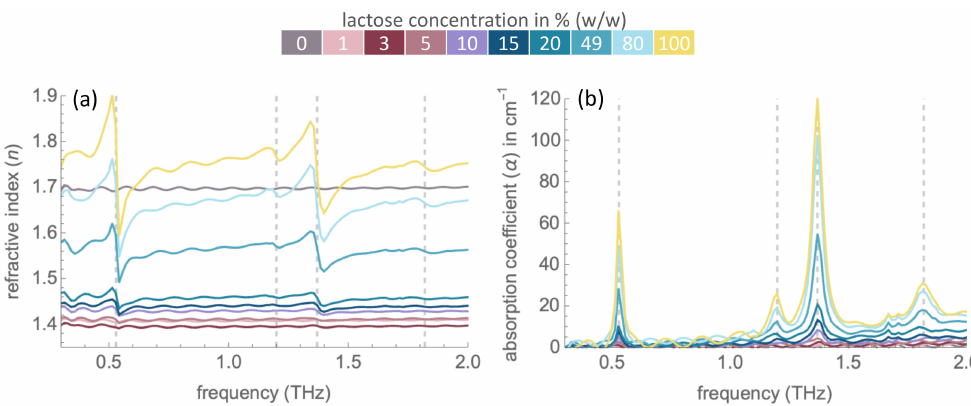
Figure 2. ( a ) THz refractive index ( n ) and ( b ) absorption coefficient ( α in cm − 1 ) spectra of α -lactose monohydrate at varying concentrations under nitrogen-rich atmosphere. Frequencies of absorption peaks (0.53 THz, 1.20 THz, 1.37 THz, 1.82 THz) are signified by vertical dashed lines. The calculation of refractive index and absorption coefficient are described in Equations (2) and (3) under Section